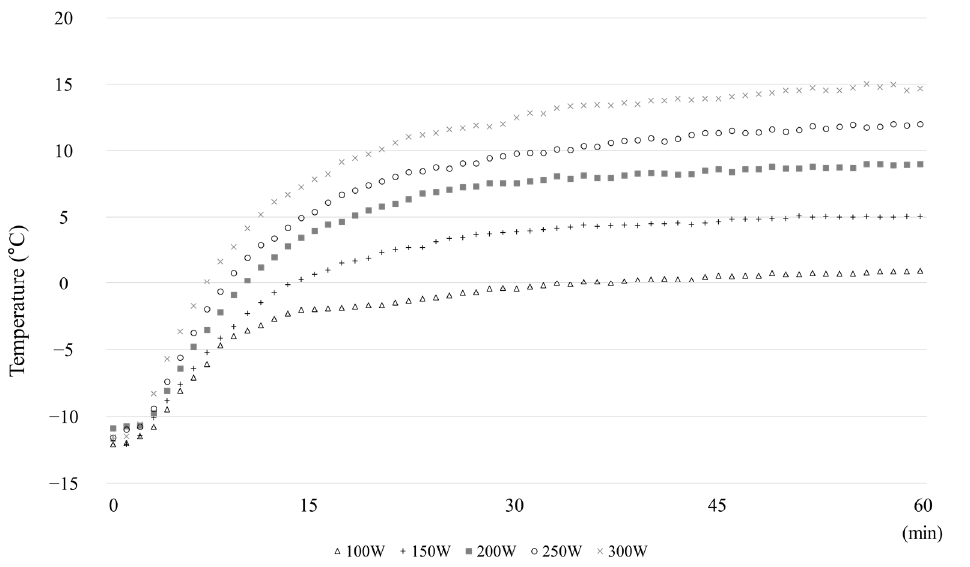
Figure 6. Changes in the internal temperature of the testing device depending on power consumption. Table 3. The heater temperatures during heating for 15, 30, 45, and 60 min according to the electric power